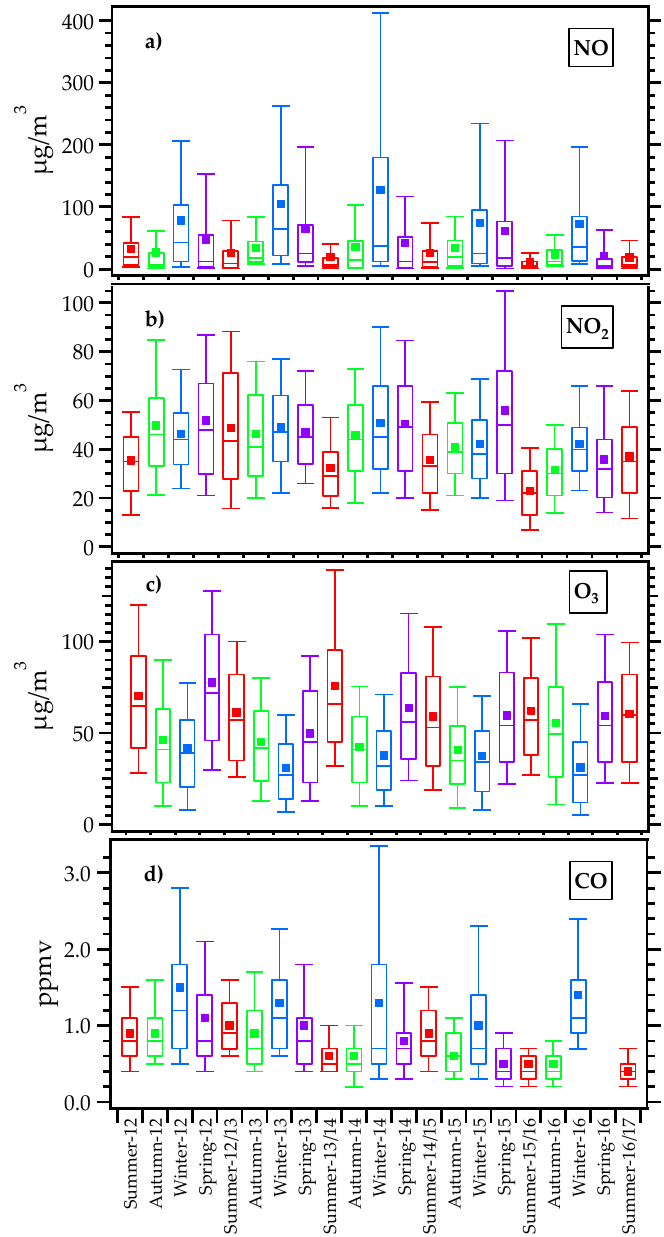
Figure 6. Box-whisker plots showing the hourly concentrations of NO ( a ); NO 2 ( b ); ozone O 3 ( c ); and CO ( d ) at the Pinheiros air quality monitoring station, color-coded by season [24]. The rectangles represent the 25th and 75th percentile values, the lines and squares within the rectangles represent the medians and arithmetic means, respectively. The whiskers indicate the 10th and 90th percentiles.